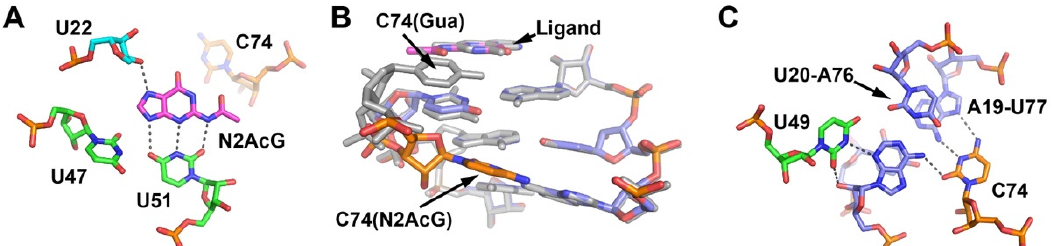
Figure 4. Crystal structure of the N 2-acetylguanine-GR complex. ( A ) Hydrogen bonding interactions between the ligand and GR. ( B ) Superimposition of the N 2-acetylguanine-GR complex with the guanine-GR complex (grey). The base of nucleotide C74 is stacked between nucleotides 73 and 75 in the guanine-GR complex, whereas in the N 2-acetylguanine-GR complex the base of C74 is situated in the major groove adjacent to the base pairs A19-U77 and U20-A76 in the P1 helix. ( C ) Hydrogen bonding interactions between C74 and two base pairs in the P1 helix.